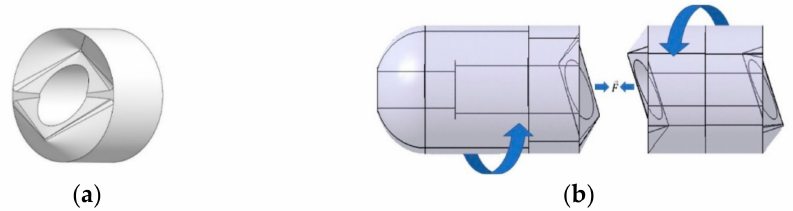
Figure 2. Schematic of the modular capsules: ( a ) Surface design with asymmetric interlocking interface. ( b ) Assembly mechanism of the modular capsules.